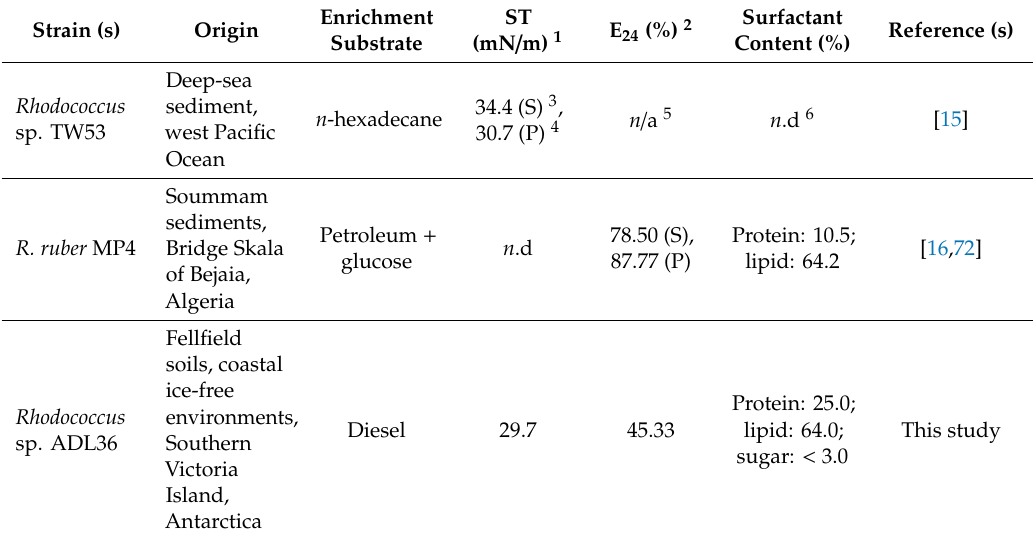
Table 3. List of surface-active lipopeptide-producing bacteria from the genus Rhodococcus . Strain (s)